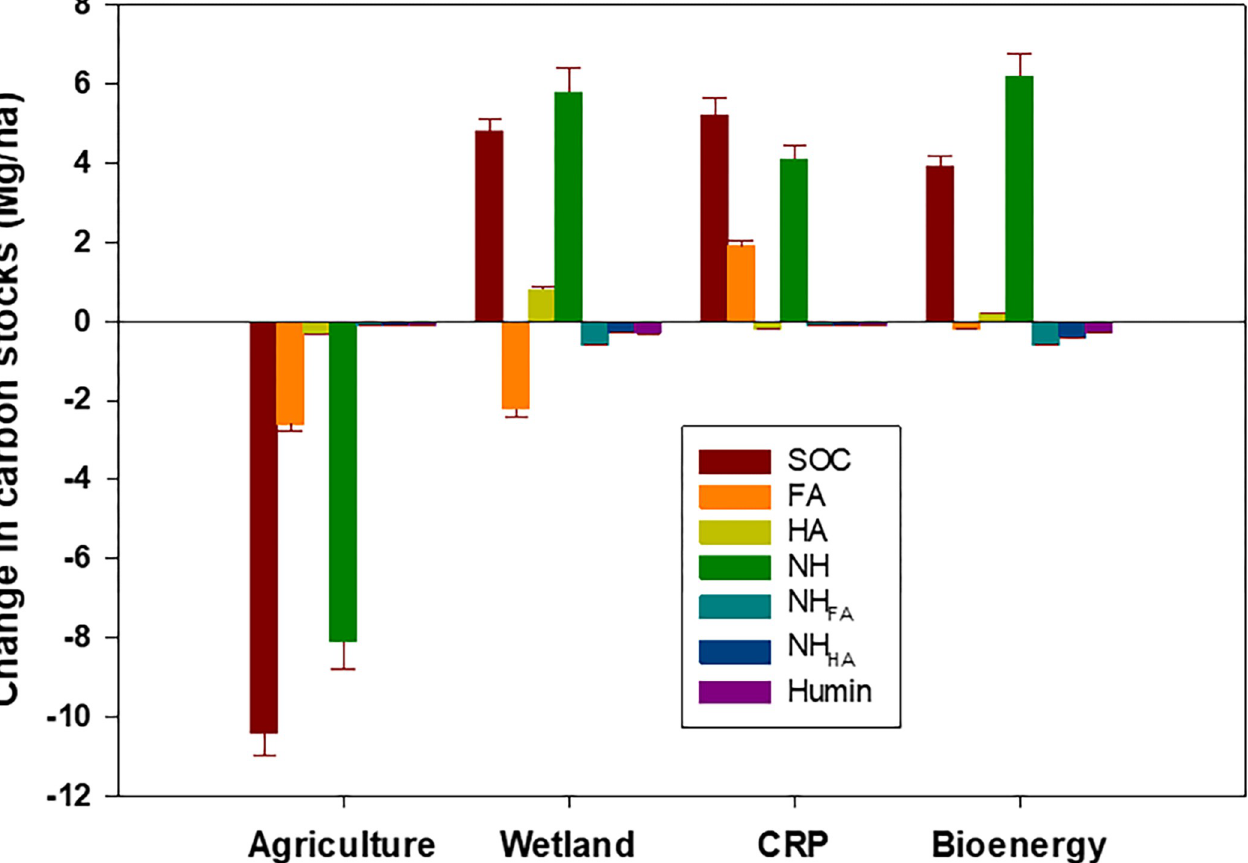
Fig 2. Impact of deforestation and subsequent land-use diversity on change in total organic carbon (SOC), total nitrogen (TN), active carbon (AC), fulvic acid (FA), humic acid (HA), humin, and glucose equivalent total non-humic carbon (NH), fluvic acid associated glucose equivalent total non-humic carbon (FA NH ), and humic acid glucose equivalent total non-humic carbon (HA NH ) stocks in soil profile (0–30 cm), relative to the forest. Data were presented with mean ± standard